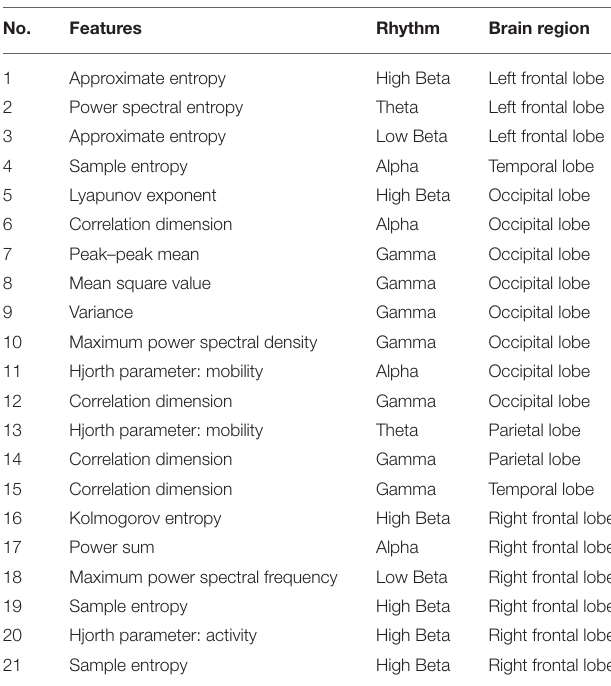
TABLE 4 | The features selected by the l 1 -regularized support vector machine under negative emotional